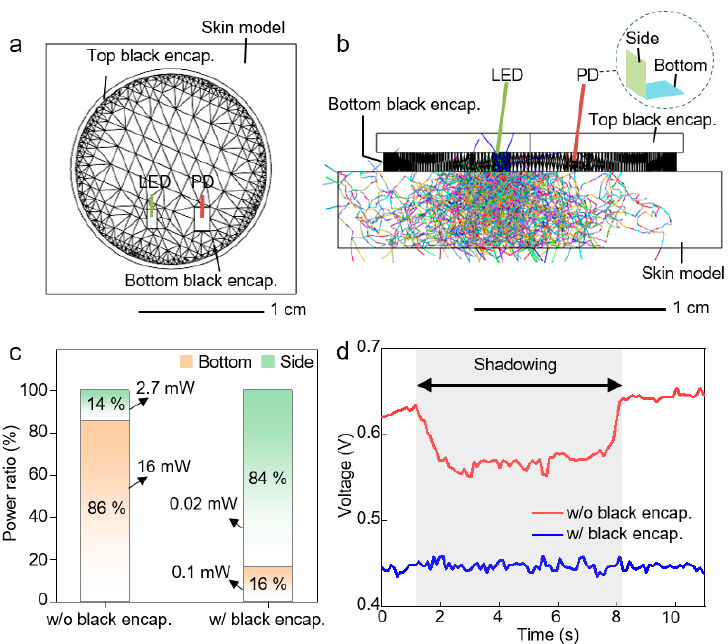
Figure 2. Investigation on the optical interference to the device. ( a ) Top image of simulation structure. ( b ) Side view of a simulation structure with 10,000 rays applied. ( c ) Detected light power at side and bottom of photodiode (PD) in both simulations with and without black encapsulation. ( d ) Measured light signal as applying shadow in both cases of the black encapsulated device and bare device.